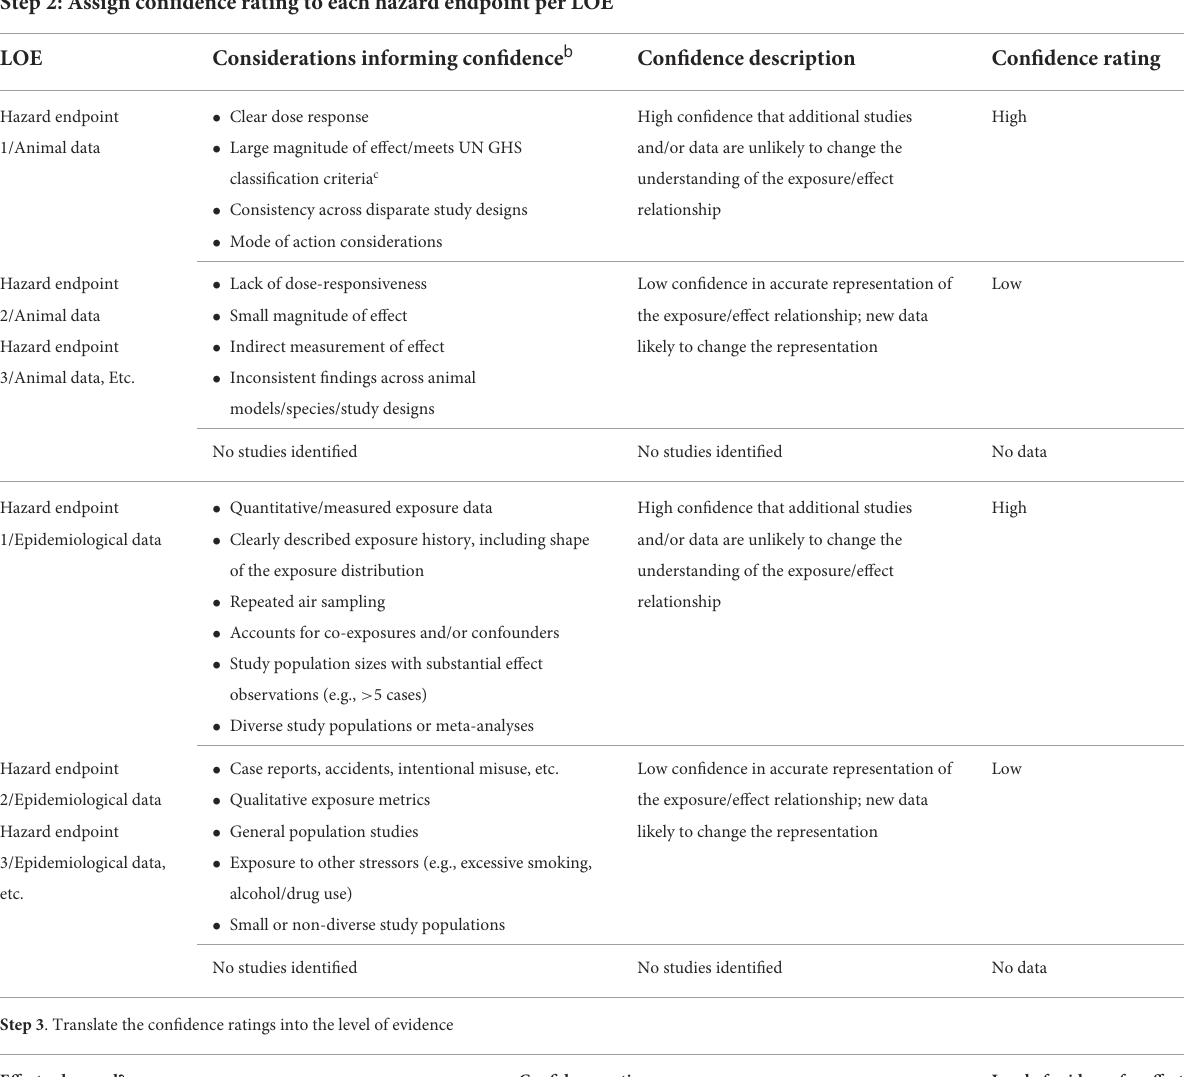
TABLE 2 A practical example to an approach to the systematic and transparent documentation of a WOE assessment a . Step 1. Establish the LOE, including quality assessment of the individual studies per